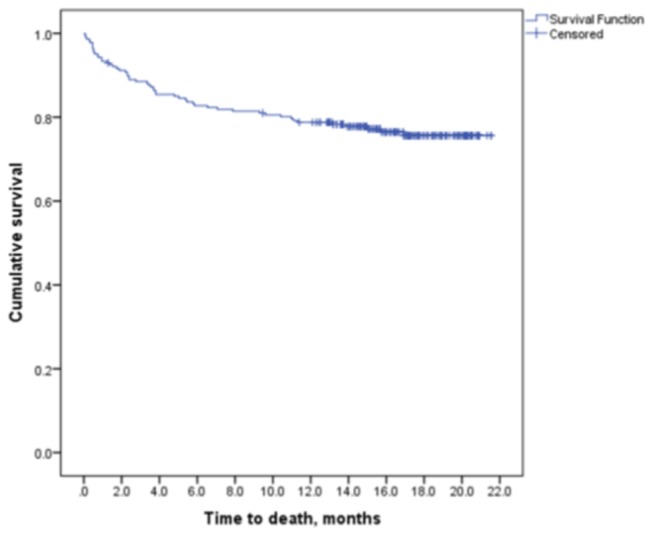
Kaplan-Meier survival curve of TB/HIV co-infected patients (n=227).